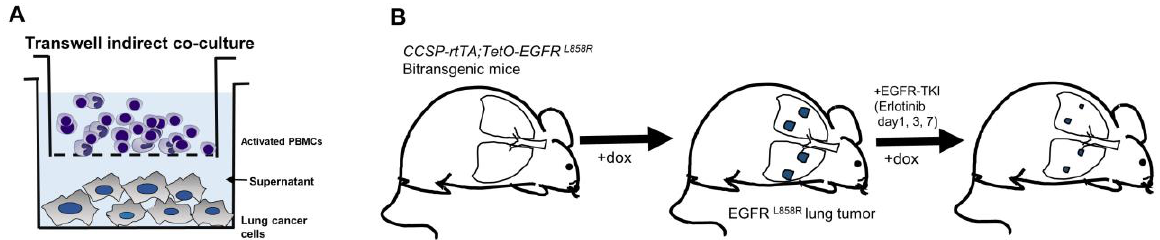
Figure 1. Strategy scheme of the experiment. ( A ) The indirect coculture model with tumor cells and activated PBMCs. ( B ) Doxycyline-inducible transgenic mice model with human EGFR L858R lung tumor.